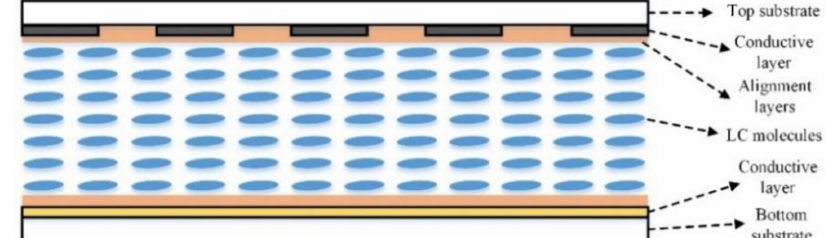
Figure 1. The general structure of liquid crystal microlens array (LCMLA), which includes top and bottom substrates with planar or patterned conductive layers, alignments layers, and a layer of LC